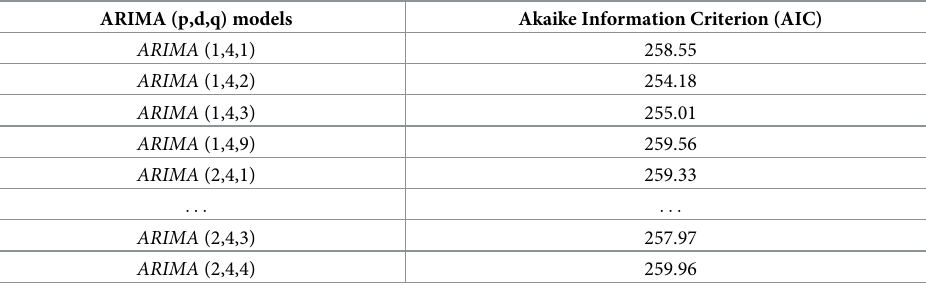
Table 5. AIC values of different ordered models for forecasting GNI.